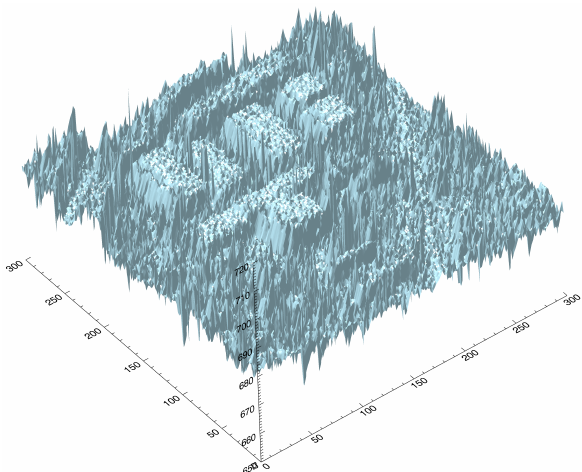
Figure 7: Three dimensional visualization of the DEM over Las Vegas for an industrial area generated using operational algo-